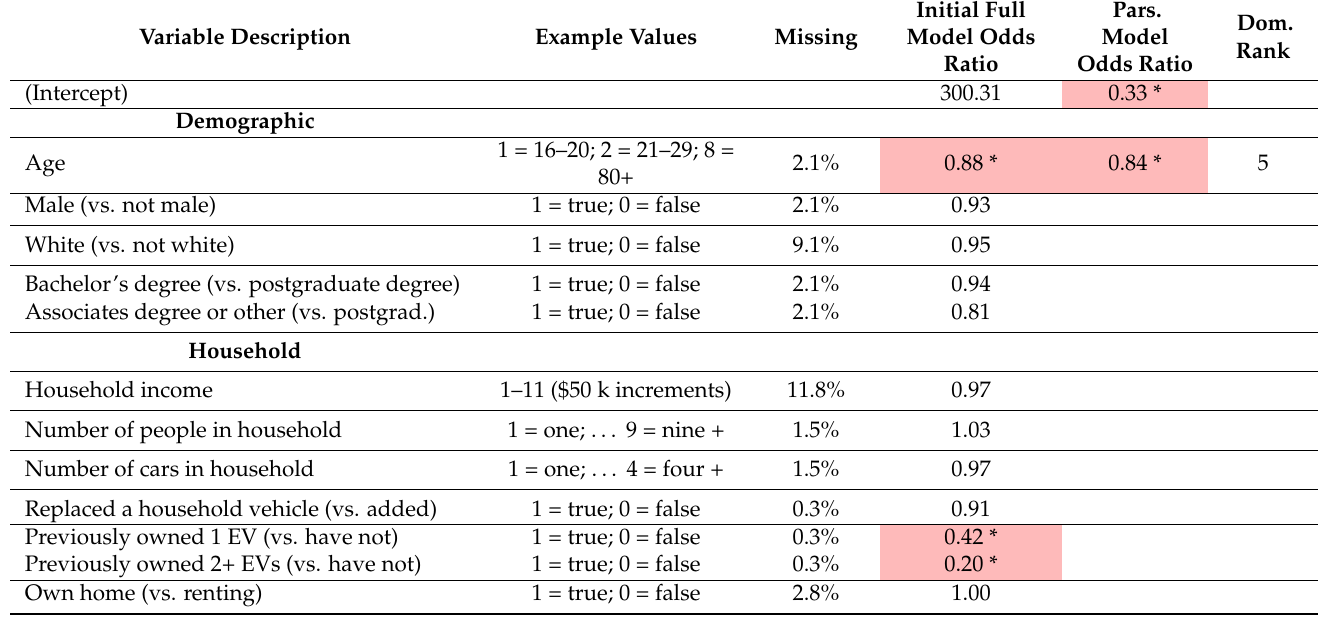
Table 5. PHEV Variables and Model